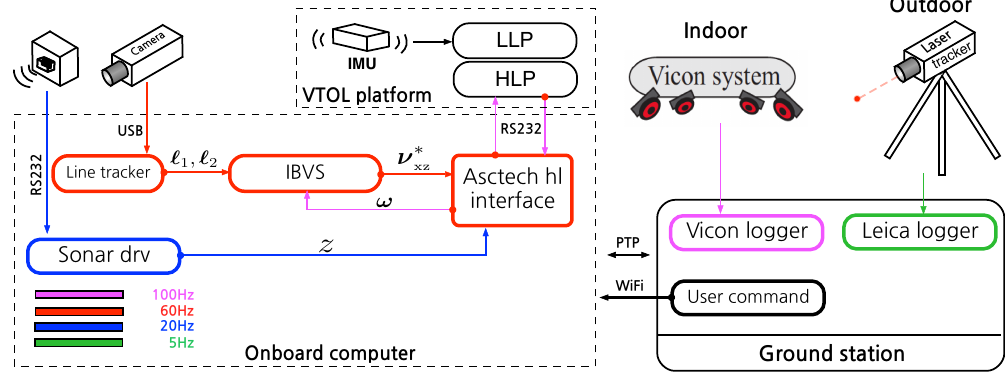
Figure 21. Sensor and software system diagram for IBVS experiments. Different colors denote different sampling